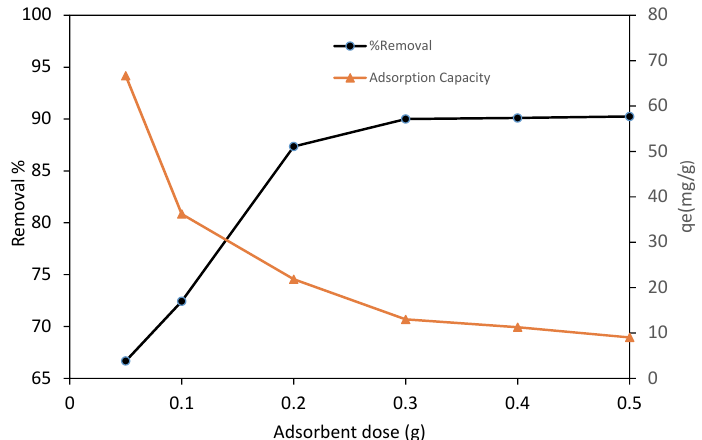
Fig. 9. The effect of contact time (kinetics of MB) onto the adsorption capacity of FS and MFS.